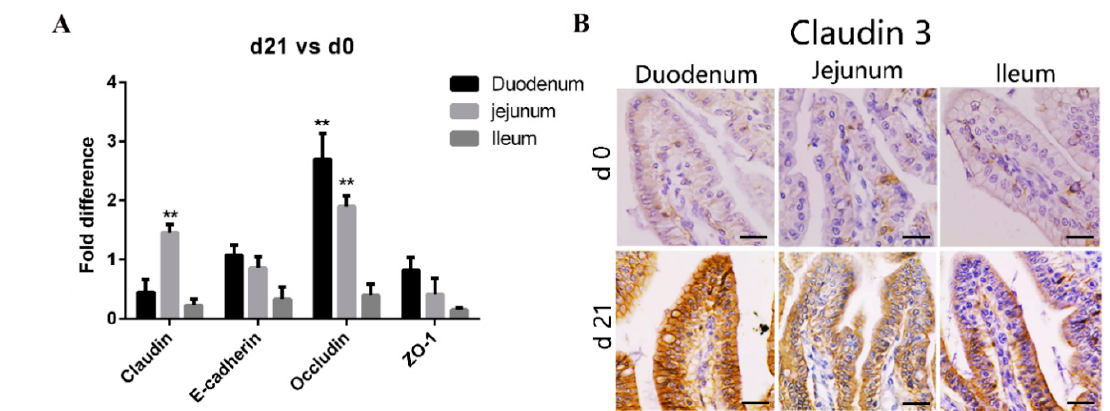
Figure 2. Differences in intestinal barrier function between neonatal and weaned piglets. ( A ) mRNA levels of claudin, E-cadherin, occludin, and ZO-1 in pig small intestine. All samples were tested in triplicate and the results are expressed as fold changes relative to the control animals. Data are presented as means ± standard errors. ( B ) Immunohistochemical staining of claudin-3 positive cells positive cell, Positive cells were quantified using densitometry analyses and were calculated in ten random fields. ( n = 10 per group). Scale bars: 20 μ m. ** p < 0.01.